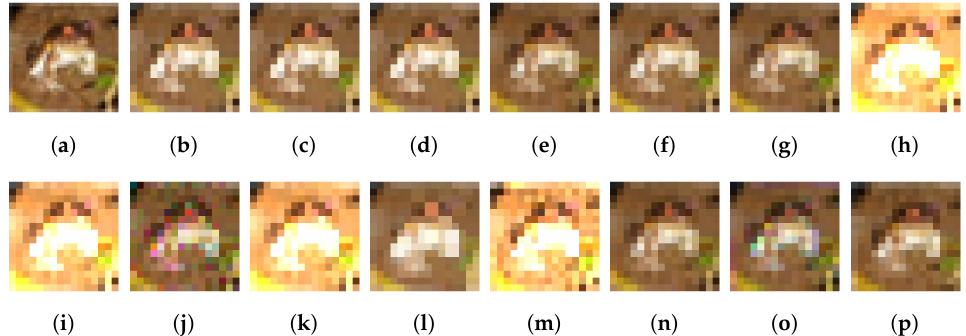
Figure 8. The CIFAR10 frog original image ( a ) and the respective results of the first pass of pooling for the methods Max ( b ), adaptive Max ( c ), fractional ( d ), Average ( e ), mixed ( f ), gated ( g ), tree ( h ), l2 ( i ), stochastic ( j ), fuzzy ( k ), overlapping Max ( l ), spectral ( m ), wavelet ( n ), LIP ( o ), and SoftPool ( p ).